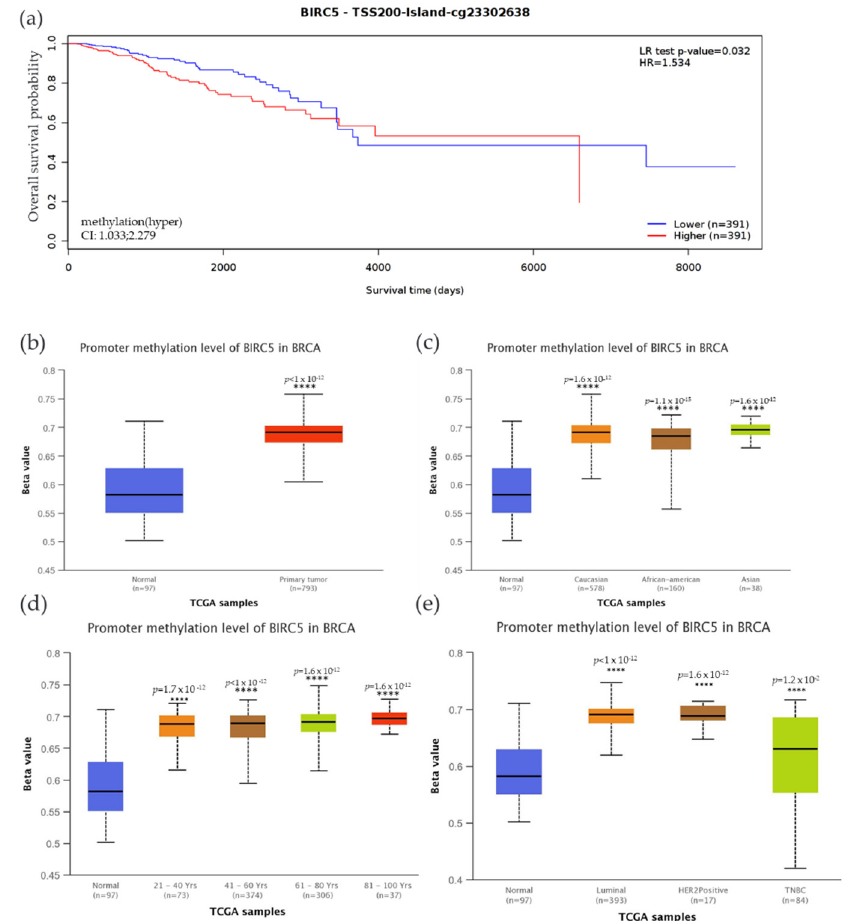
Figure 8. Methylation status of the BIRC5 gene. ( a ) BIRC5 methylation is associated with a decrease in the survival of BC patients. ( b ) The BIRC5 gene was also considerably hypermethylated ( p < 1 × 10 − 12 ) in comparison to the normal tissues. Analysis of the relationship between the methylation status at CpG foci and the expression of the BIRC5 showed that hypermethylation was associated with hormone status ( c ), age ( d ), and race ( e ). **** p < 0.0001.